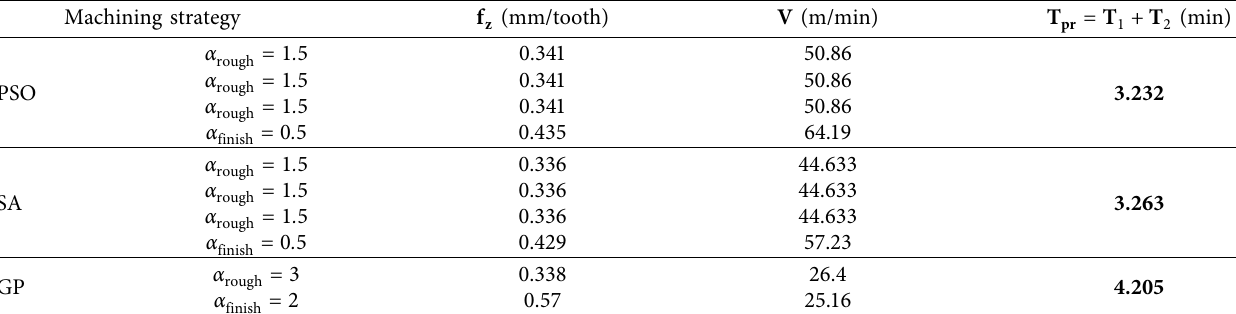
Table 4: Computational results of IPSO, SA, and